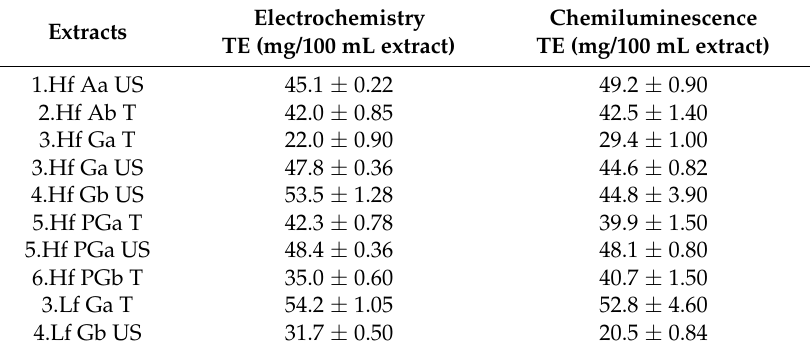
Figure 11. Histogram of CL determinations in terms of Trolox equivalent, for lavender and sea buckthorn extracts. Table 4. TE equivalent for some of the lavender and sea buckthorn extracts. Table 4. TE equivalent for some of the lavender and sea buckthorn extracts.